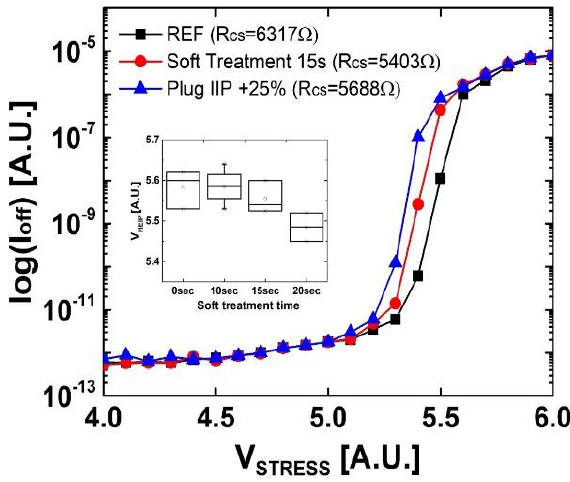
Figure 8. I-V curves for HEIP reliability. VHEIP as a function of processing time (inset).